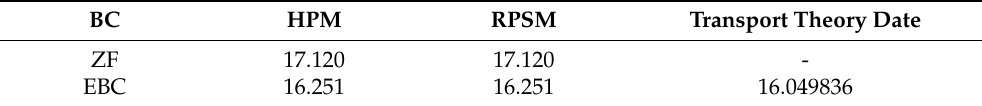
Table 9. Critical radius of two-group bare reactor.